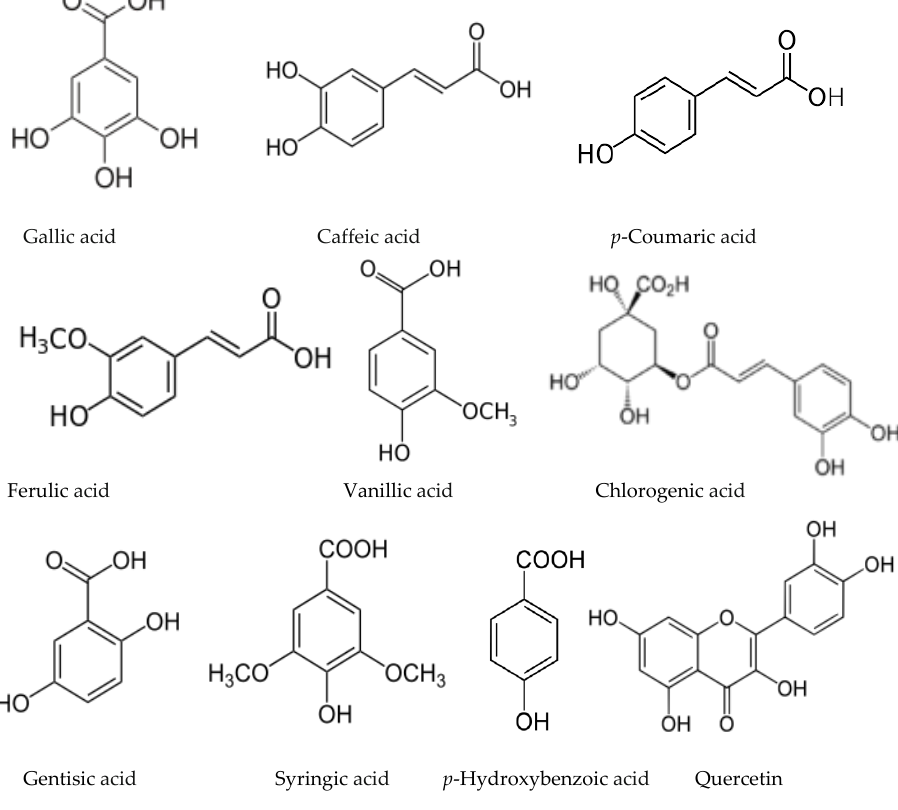
Figure 6. Phenolic allelochemical compounds.